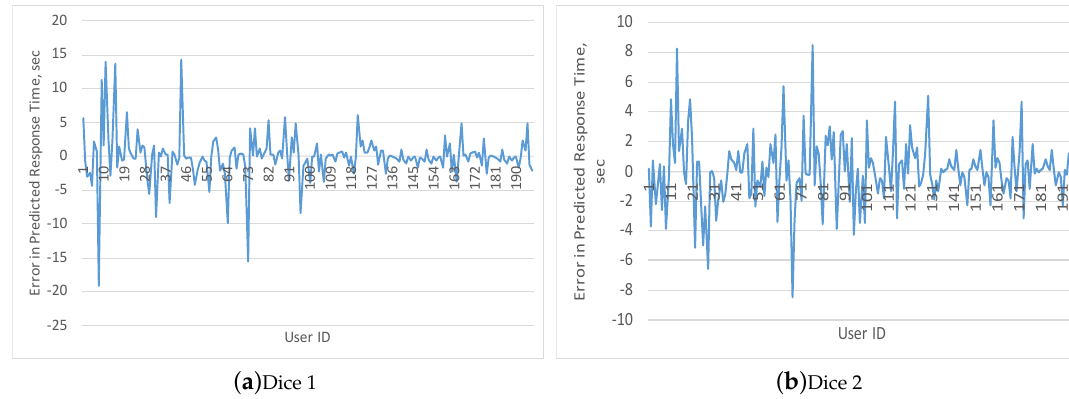
Figure 10. Trend of the error computed as target—predicted solution time over the Internet users.